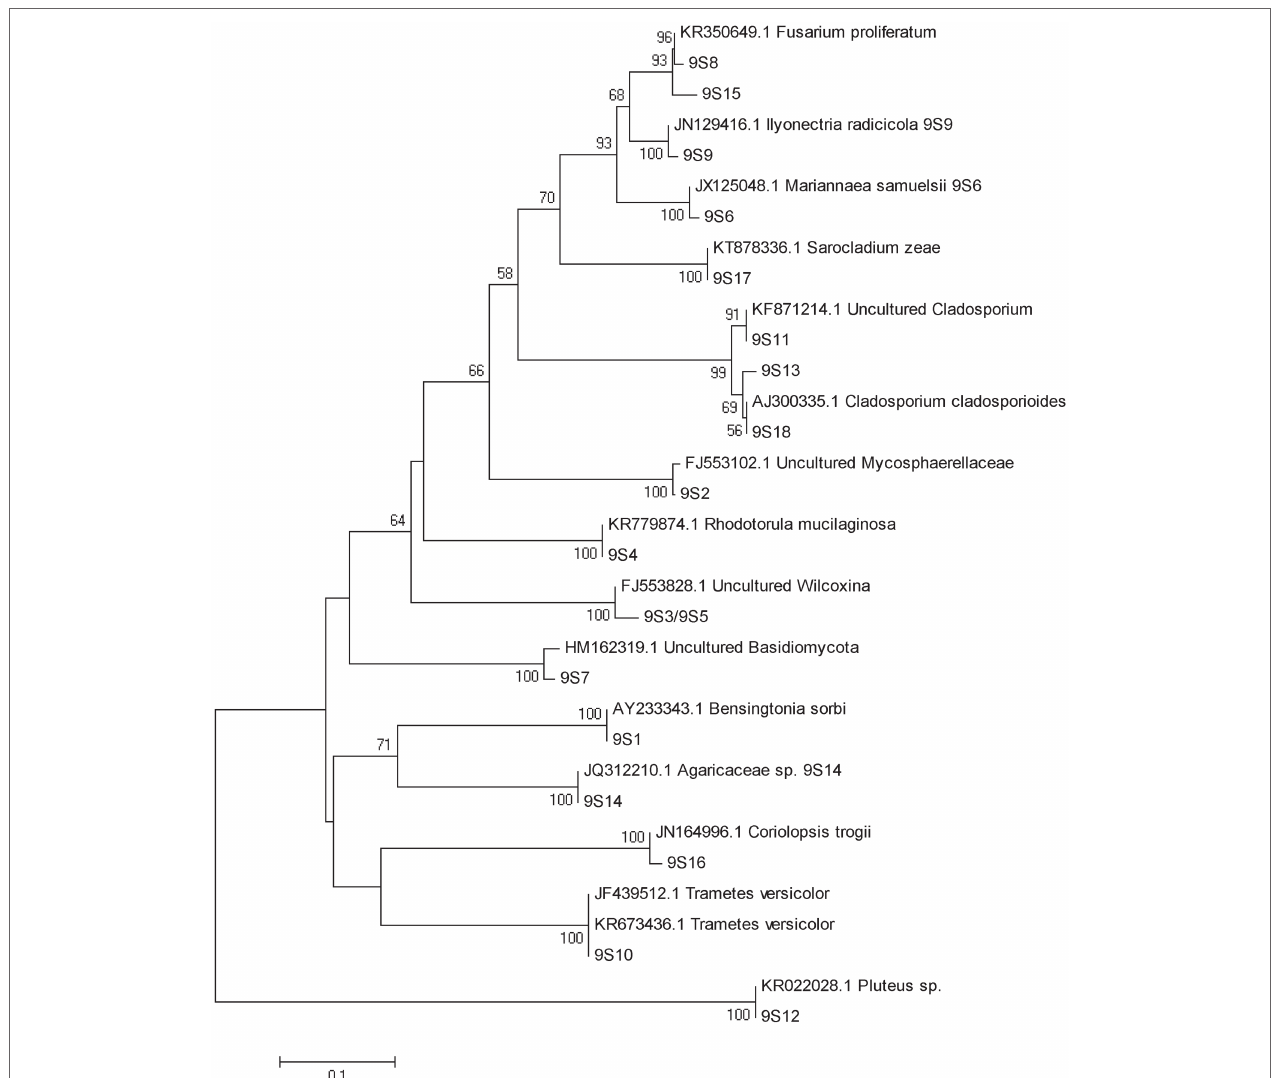
FIGURE 8 | Neighbor-joining phylogenetic tree of fungi at 9 months after PWN infection.